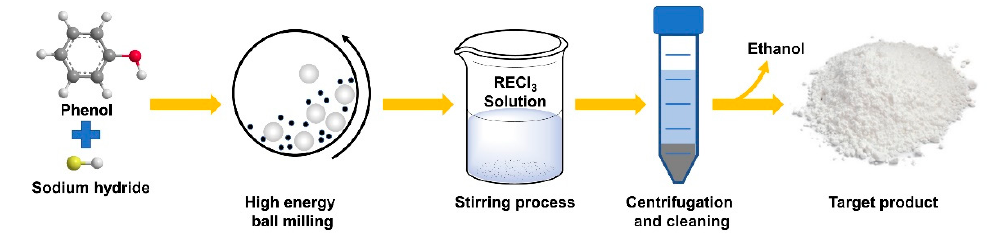
Figure 1. Schematic diagram of preparation method for rare-earth organic compounds.